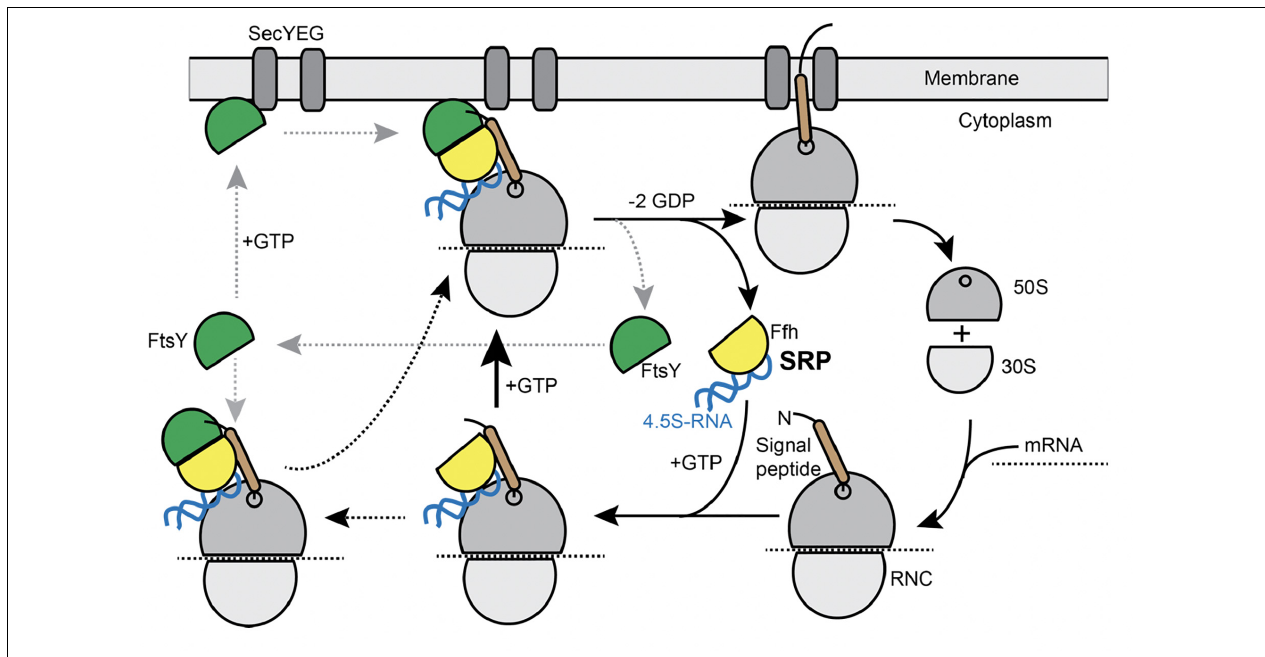
FIGURE 1 | Model for the SRP cycle. Lower part from right to left: ribosome subunits binding to mRNA form the 70S particle, to which SRP binds upon detection of the signal sequence at the nascent chain (“signal peptide”). This complex binds to FtsY, either within the cytosol, as indicated by the leftwards arrow, or at the cell membrane. GTP hydrolysis triggers hand over of the ribosome nascent chain complex to the SecYEG translocon (upper part), upon which SRP and FtsY are released. Our data suggest that complex formation of SRP/RNC and FtsY can occur within the cytosol and also at the